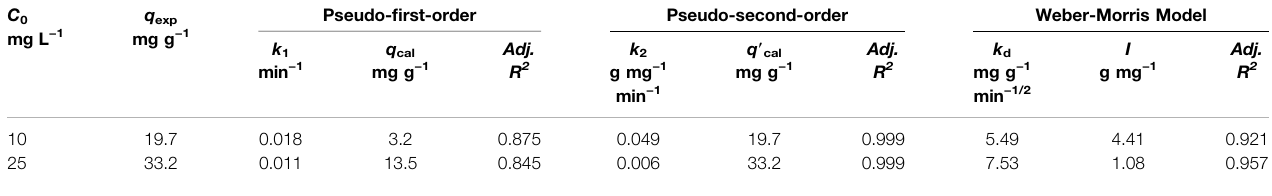
TABLE 3 | Fitting parameters of Pb(II) adsorption kinetics on Fe 3 O 4 @SiO 2 -MnO 2 (1.54) using pseudo- fi rst-order, pseudo-second-order, and Weber-Morris